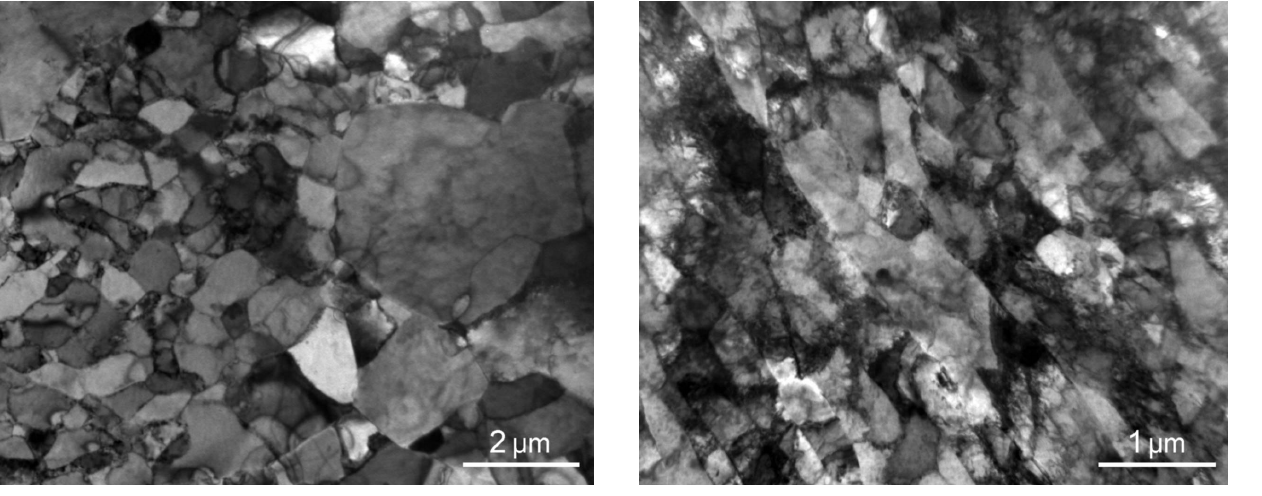
Figure 18: Bi-modal dislocation structure after constant plastic strain amplitude loading.